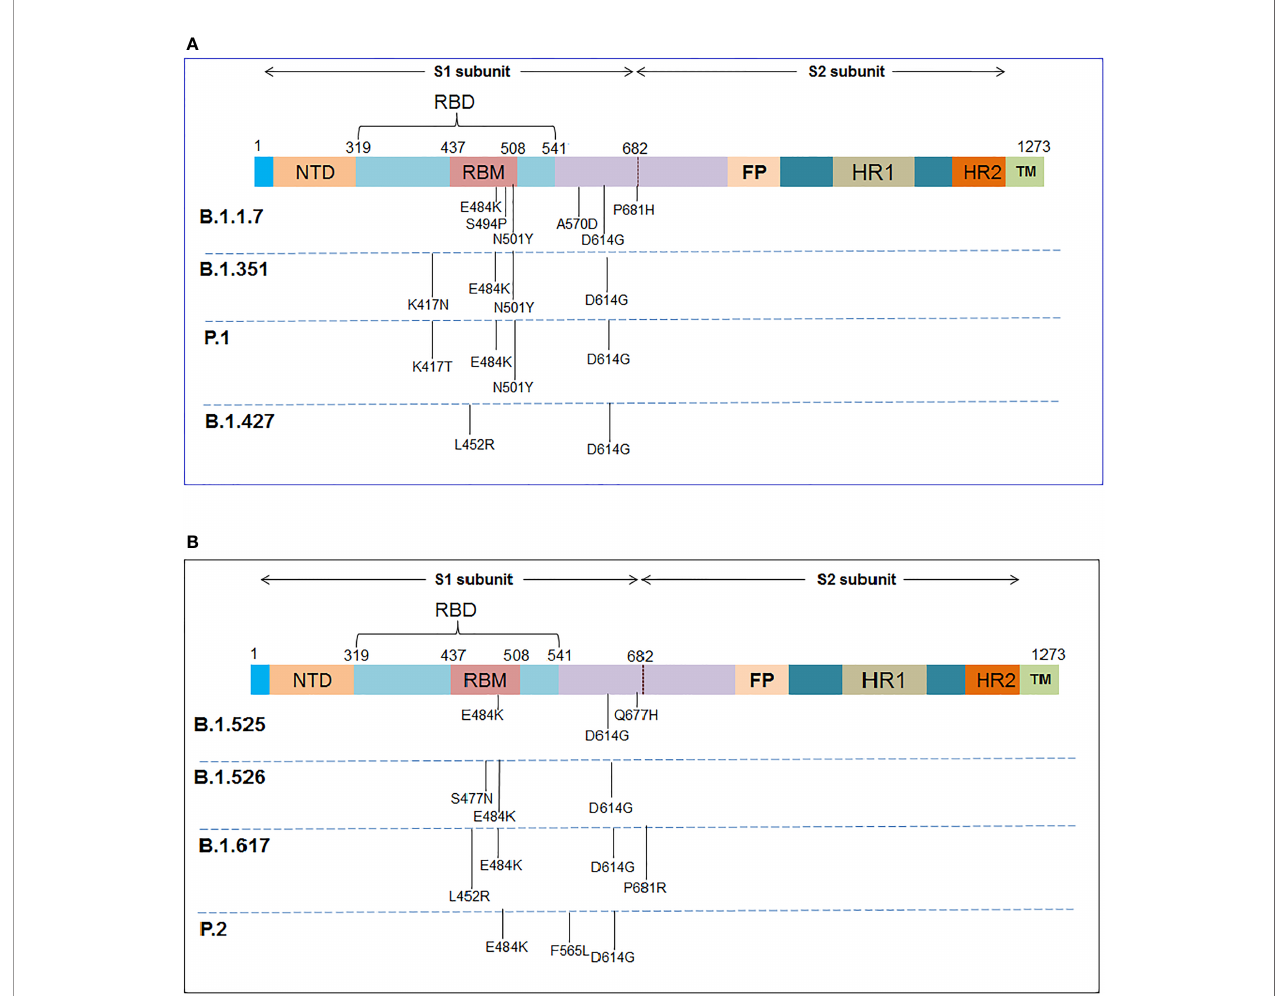
FIGURE 4 | The schematic diagram illustrates the signi fi cant mutations in the S-glycoprotein as noted in the VOCs and VOIs. (A) Reported essential mutations in the S-glycoprotein of VOCs. (B) Reported critical mutations in the S-glycoprotein of